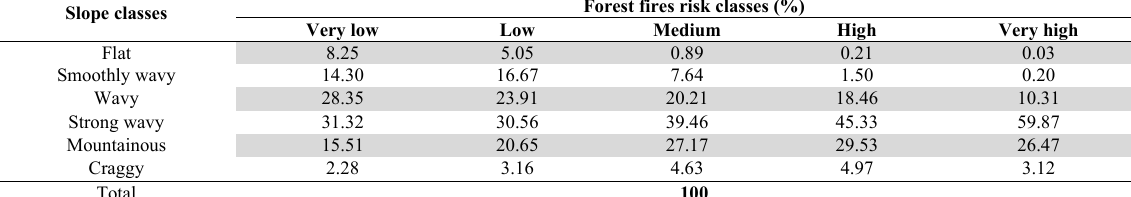
Spatial relationship between forest fires risk classes and slope in Amojú river basin, Cajamarca region. Slope